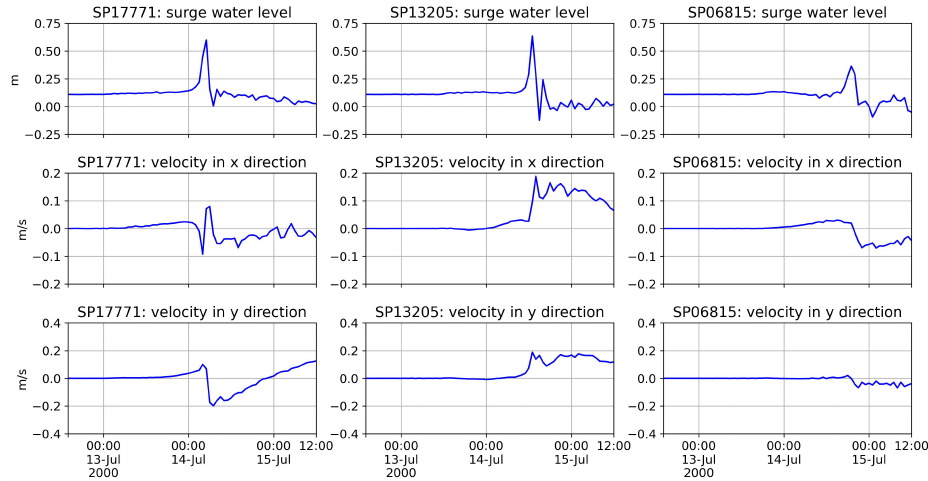
Figure 4. The corresponding storm surge water level (top row), velocity in the x-direction (middle row), and velocity in the y-direction (bottom row) induced by storm 1011 at the three save points: SP17771, SP13205, and SP06815 from the left to right, respectively. The results were simulated by using the ADCIRC